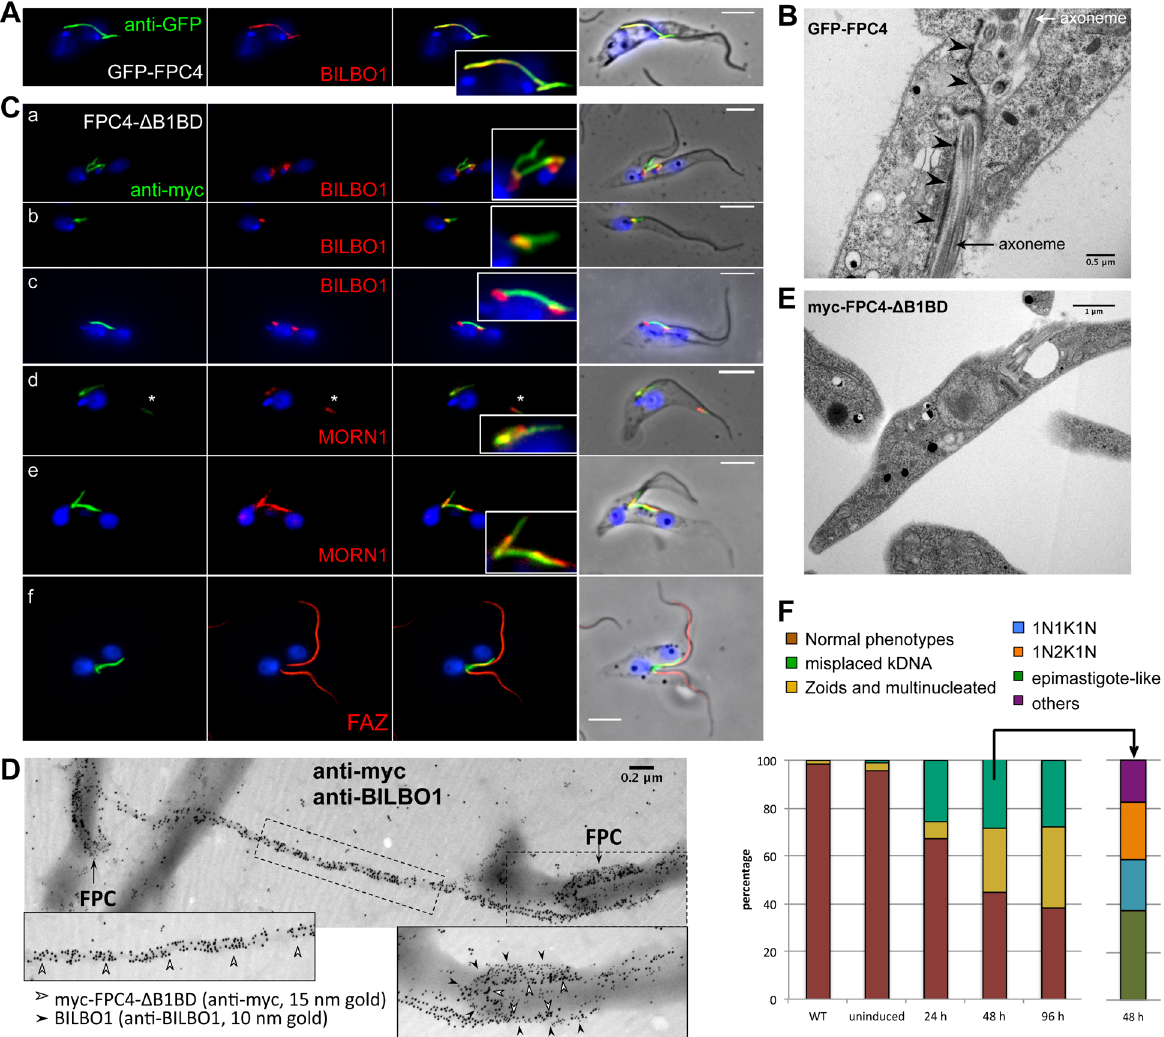
Fig 6. The overexpression of FPC4- Δ B1BDinduced morphological phenotypes. (A) Co-localisation of GFP-FPC4 (anti-GFP, green) and BILBO1 (anti-BILBO1, red) by immunofluorescence on cytoskeletons. The cells were inducedto express GFP-FPC4 for 48 h. (B) Transmission electronmicrographof a thin section of embedded cells that were over-expressing GFP-FPC4 (72 h of induction).Black arrowheadshighlightthe electron densestructure observed in these cells resemblingthe filament observedby immunofluorescence. (C) Co-localisation of myc-FPC4- Δ B1BD(anti-myc, green) and BILBO1 (red), MORN1 (red) and FAZ (red) by immunofluorescenceon cytoskeletons. The cells were inducedfor 48 h. Several phenotypeswere observed: filament connection between2 FPCs (a, c, e), epimastigote-like cells (b), and localisation of myc-FPC4- Δ B1BDtogether with MORN1 at the distal end of the cell body (d). Abnormal cells still exhibitFAZ structures that were positivelylabelledwith L3B2 (f). (D) Immuno-electron microscopy localisation of gold particles of myc-FPC4- Δ B1BD (anti-myc, 15 nm gold) and BILBO1 (anti-BILBO1, 10 nm gold) on isolatedflagella from cells expressingmyc-FPC4- Δ B1BD.(E) Transmissionelectronmicroscopy of thin sections of embedded cells over-expressing myc-FPC4- Δ B1BDshowingan epimastigote-like phenotype. (F) Counts of cells showingdifferent phenotypes related to kinetoplast positioning.Normal phenotype (brown - 1K1N, 2K1N, and 2K2N cells where cell morphologywas normal), abnormal(yellow—Zoids and multinucleated), and abnormal (green—misplaced kinetoplast) for WT and non-induced and induced(24, 48, and 96 h) myc-FPC4- Δ B1BD over-expressing cells. The misplaced kinetoplast category was then dividedinto subcategories (48 h induction). Kinetoplasts and nuclei were DAPI stainedand scale bars represent 5 μ m in A and C. Initial immuno-localisationswere performed on two individual clones. phenotypic similarities were observed; for example, (a) a fibre connecting the two FPCs, and (b) formation of epimastigote-like cells. We occasionally observed the localisation of myc-